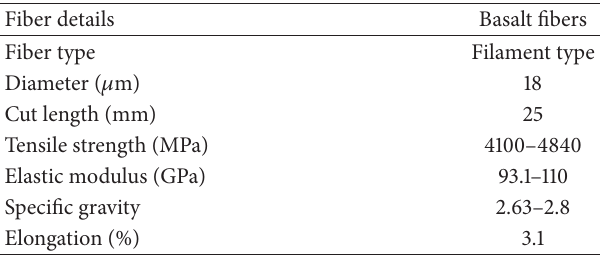
Table 2: Properties of Basalt